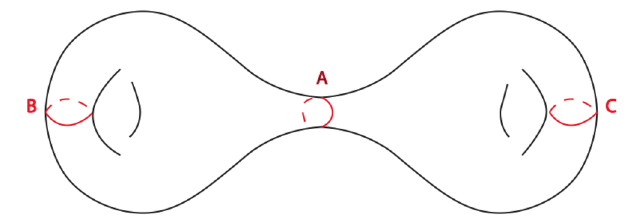
Figure 2 . A genus two surface M with three nonintersecting and homotopically independent one- cycles labeled A , B , and C . M is the conformal boundary of a hyperbolic three-manifold X . If X is such that V ( X ) → −∞ when A is pinched, then the contribution of X to Z ( M ) has a part R